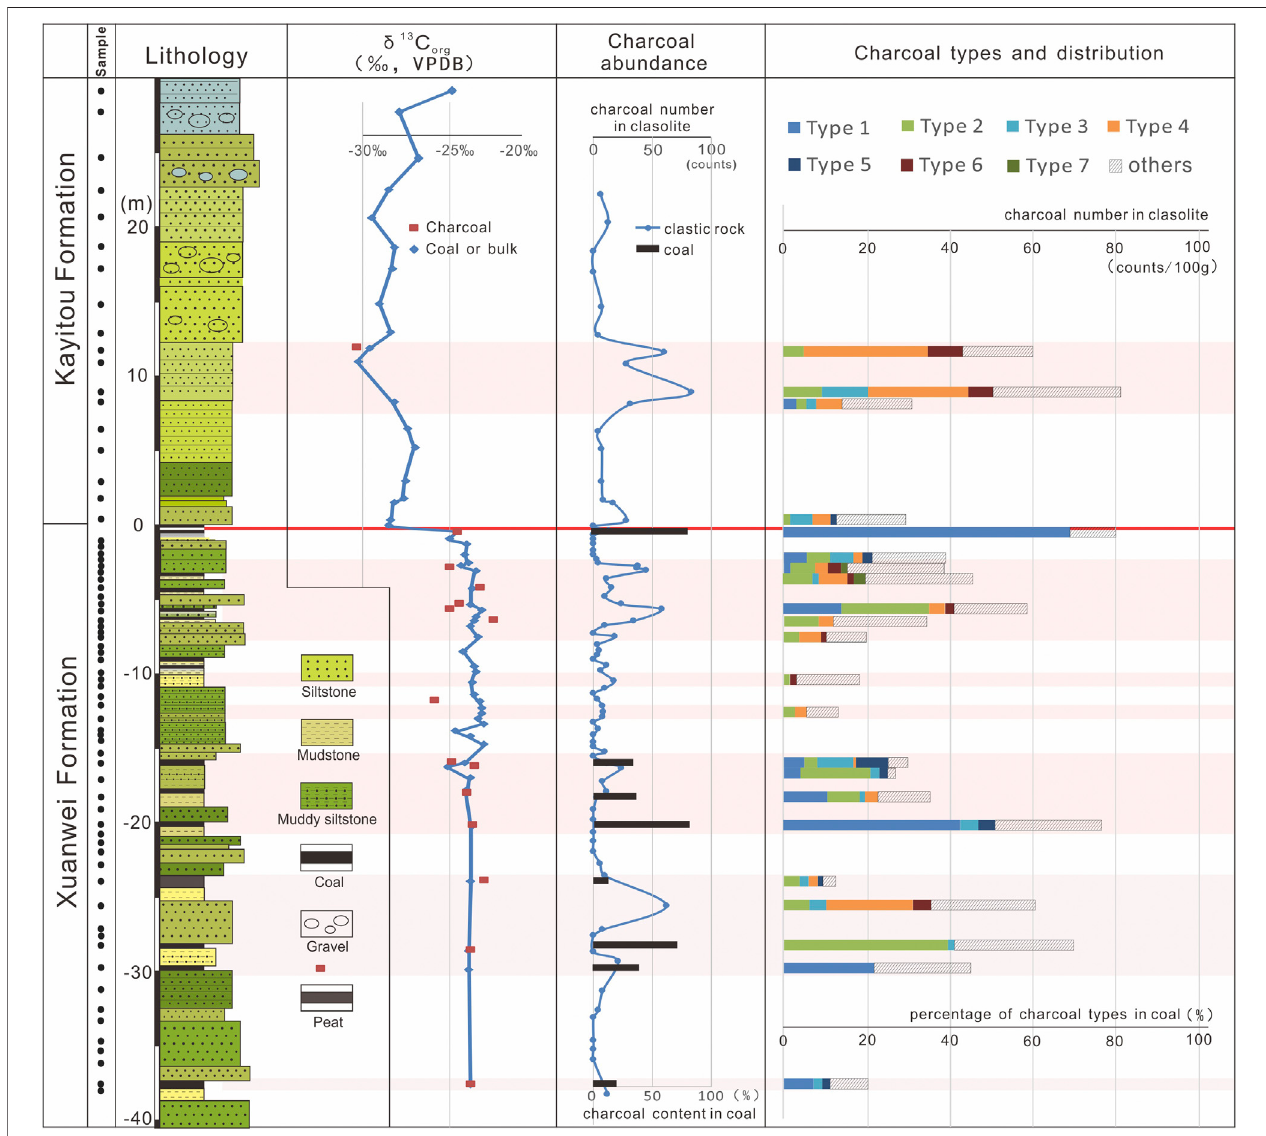
FIGURE5| Stratigraphiccolumnandtheorganiccarbonisotopes( δ 13 C org ),charcoalabundanceandtypesoffossilcharcoalsintheLengqinggousection,Guizhou Province, Southwest China. The diagram shows sediment logs and thickness in meters. δ 13 C org of charcoals are represented by red squares, whereas δ 13 C org of coals or bulk rocks are represented by blue rhombuses. The red line represents the position of ash bed in the last coal. Charcoal abundance is counted by numbers in per 100 g samples (clastic rocks) and percentage in residues after acid treatment (coals).